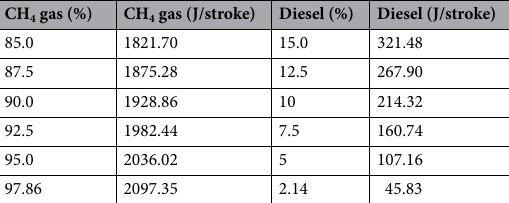
Table 5. The optical engine experimental condition of fuel mixture